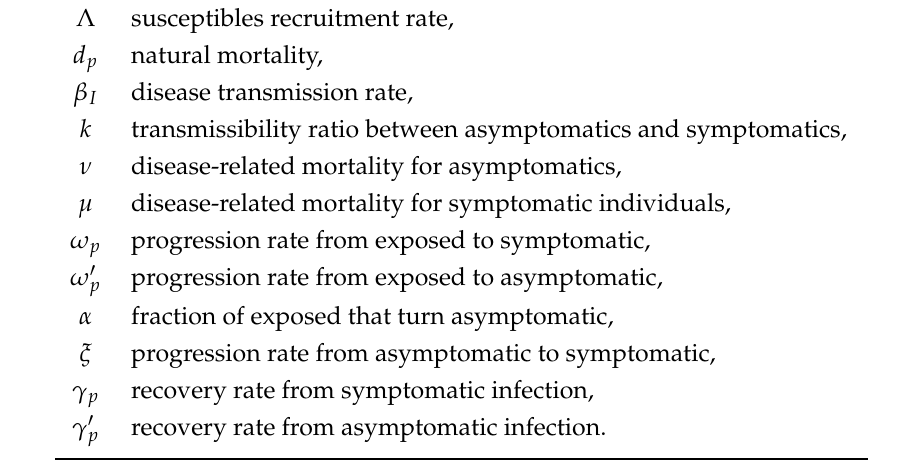
Figure 1. The basic interactions among the compartments. Table 1. Model parameters and their